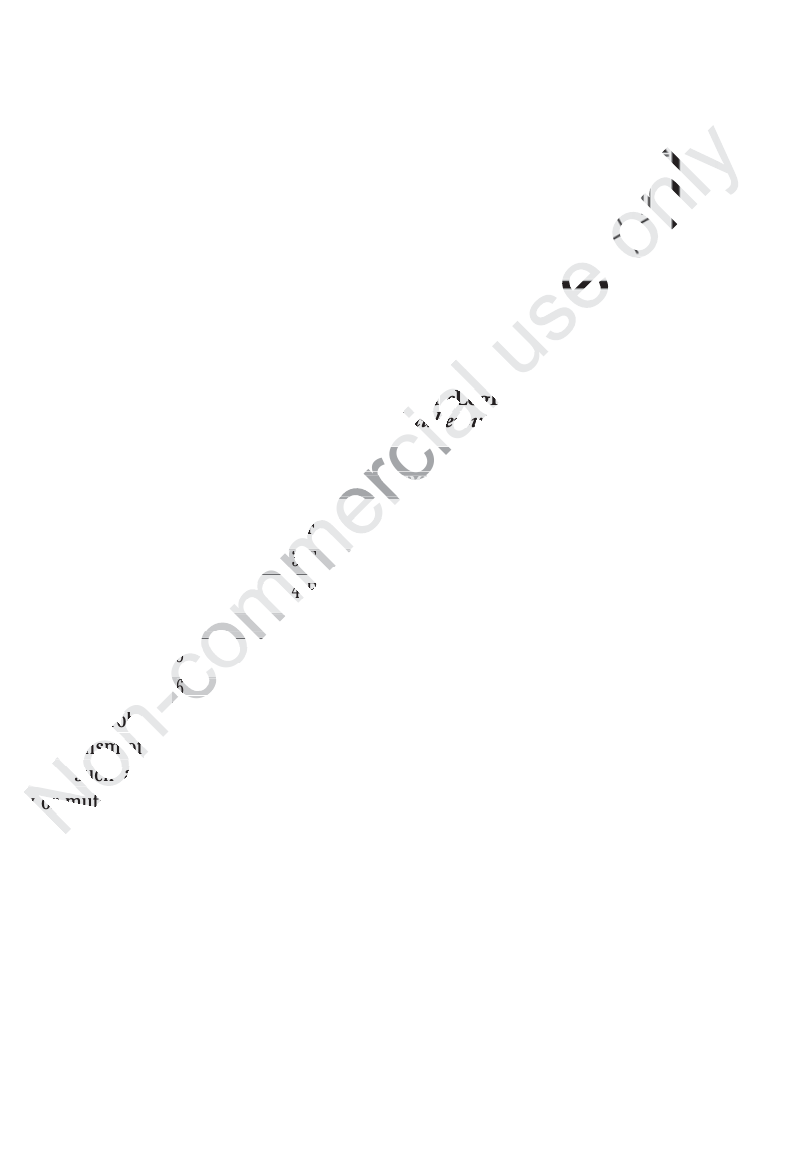
Figure 1. Design concept of N- acylhidrazones isoniazid deriva-